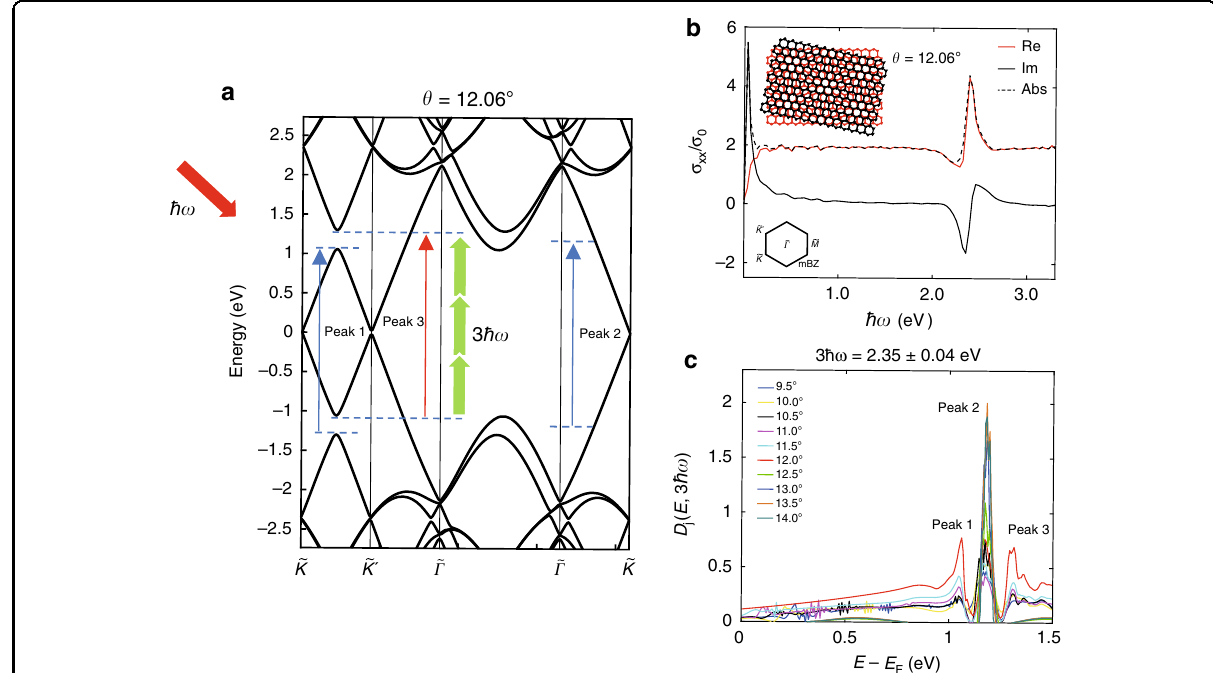
Fig. 3 Enhanced THG in tBLG via resonantly increased linear optical conductivity. a Schematic of the energy band diagram of tBLG when the energy gap of the VHS matches the three-photon energy of the incident light. b Resonantly increased linear optical conductivity in tBLG with a twist angle of 12.06° calculated by the continuum model method. Inset: schematic of Moiré superlattices formed at the interface of tBLG with a twist angle of 12.06°. c Joint density of states of tBLG for different twist angles between 9.5° and 14°. The three peaks are denoted by the three arrows in ( a